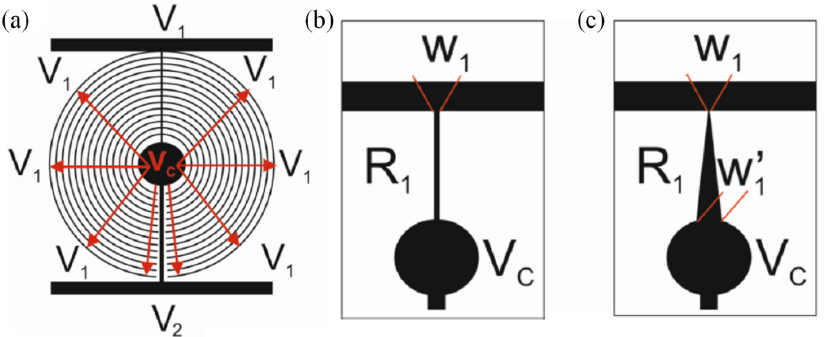
Figure 8. Schematic depiction of the ( a ) voltage-dividing electrode. ( b ) Rectangular transmission line. ( c ) Triangular transmission line [56]. Reprinted with permission from Ref. [56]. 2020 Springer Nature.